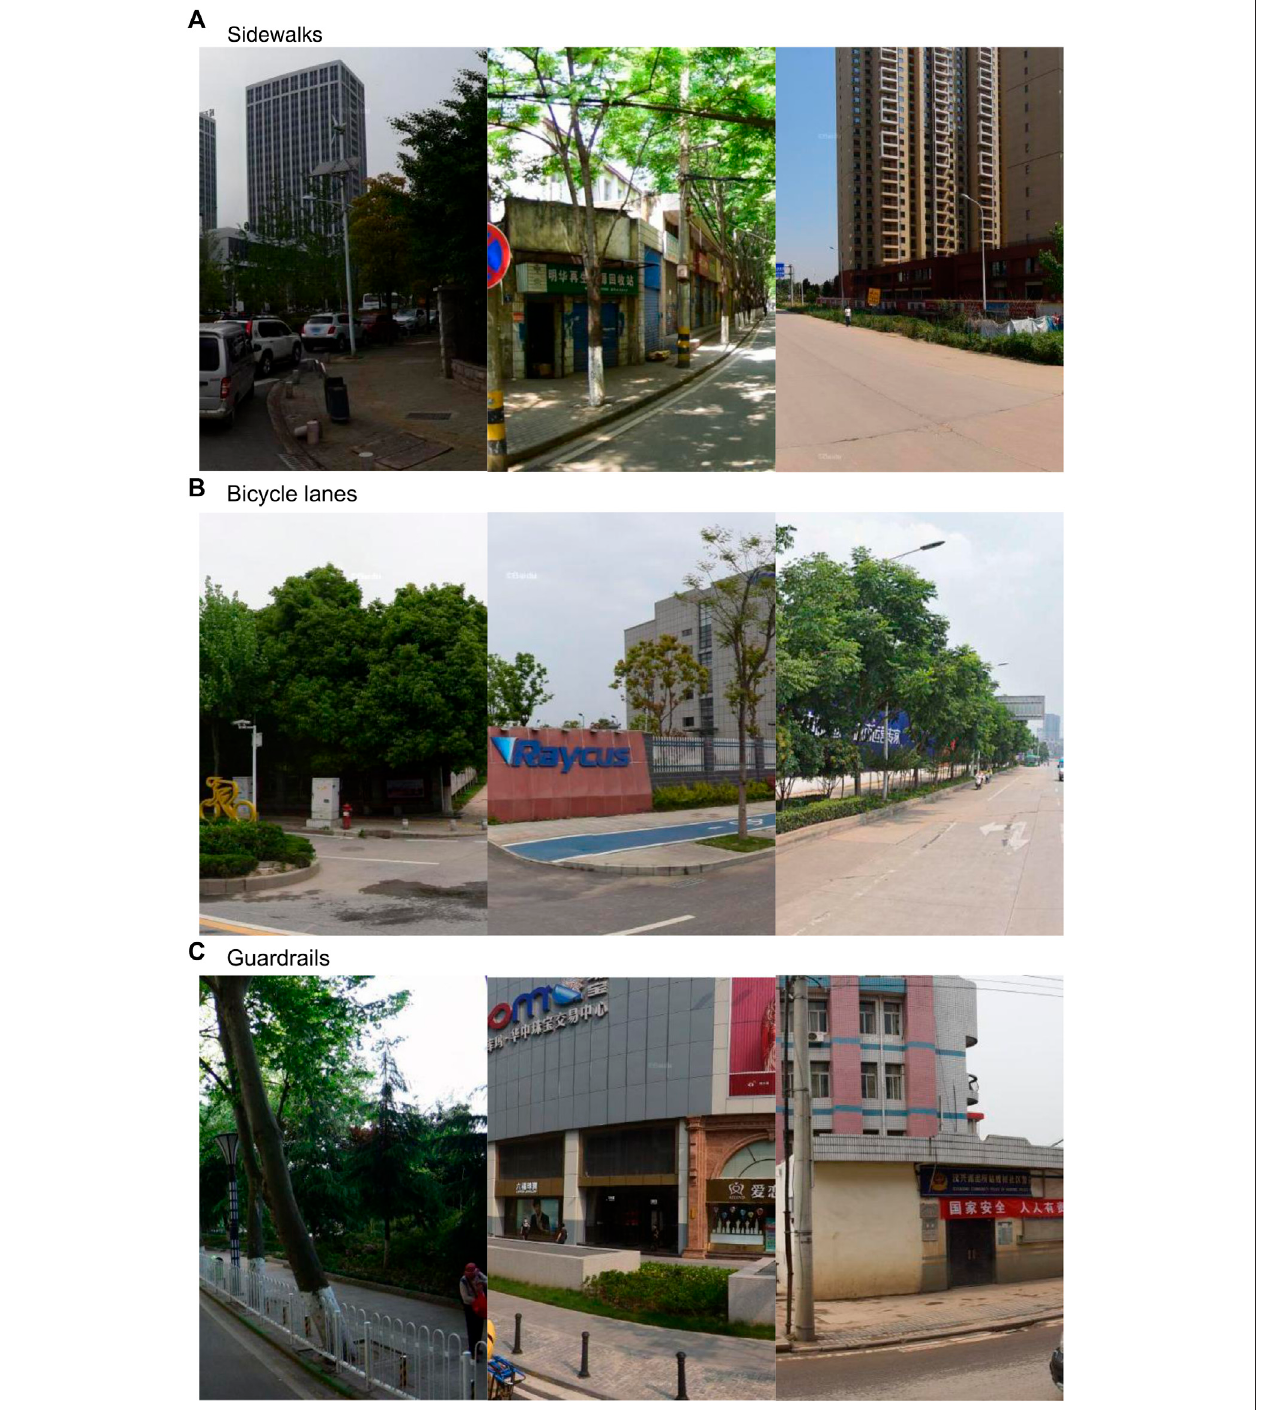
FIGURE 3 | Interpretation of the street view (from left to right is good, medium, and bad). (A) Sidewalks, (B) bicycle lanes, and (C) guardrails.